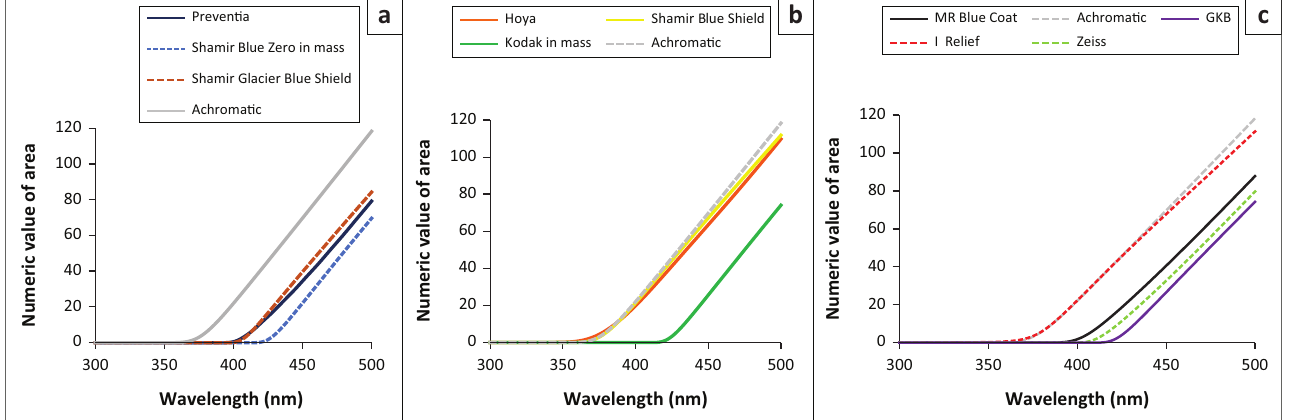
FIGURE 3: Cumulative plots a, b and c for all lenses ( N = 11) indicated by a number showing the area of the light transmitted beneath the transmittance curves in Figure 3. The achromatic lens (in grey) is the control lens. TABLE 2: Cumulative plots showing the area of the light transmitted beneath the transmittance curve in Figure 3 indicated by a number. Type of lens Kodak in mass GKB Note: The numbers in brackets in the second column categorises the area from least transmittance up to 460 nm and the total area up to 500 nm in column 3.